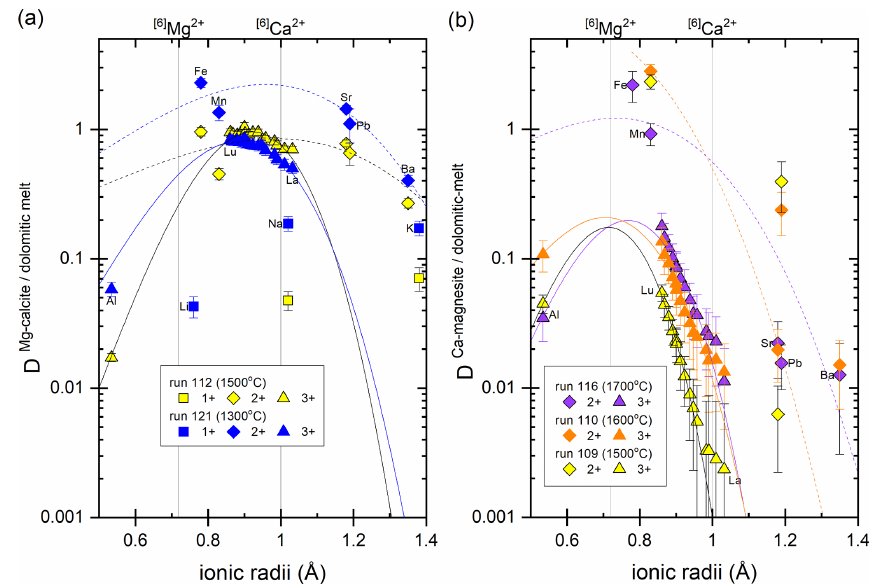
Figure 6. Partition coefficient at 9GPa as a function of ionic radii for (a) Mg-calcite and carbonate melt (run 112, 121) and (b) Ca-magnesite and carbonate melt (run 116, 110, 109).